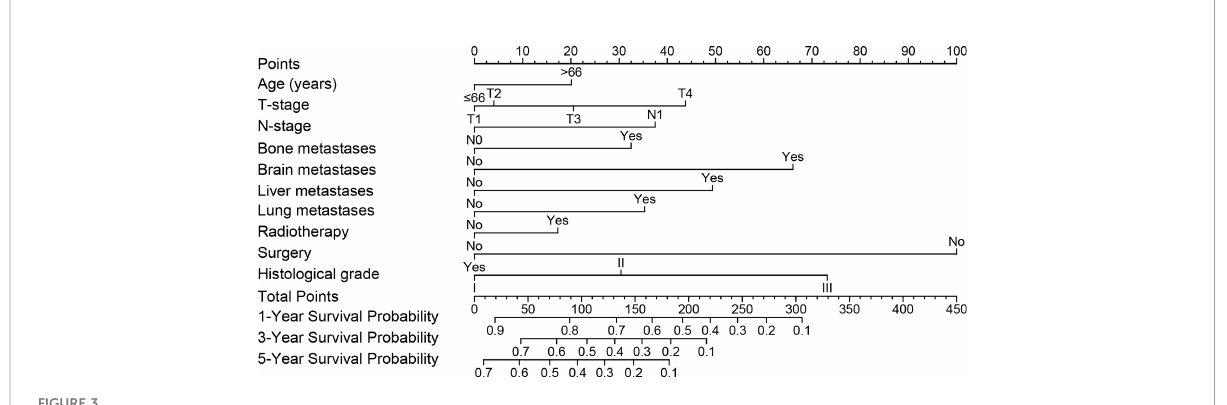
FIGURE 3 Nomogram model was constructed using the independent prognostic factors predicting the 1-, 3- and 5-year CSS for patients with mccRCC.CSS, Cancer-Speci fi c Survival; mccRCC, metastatic clear cell renal cell carcinoma.